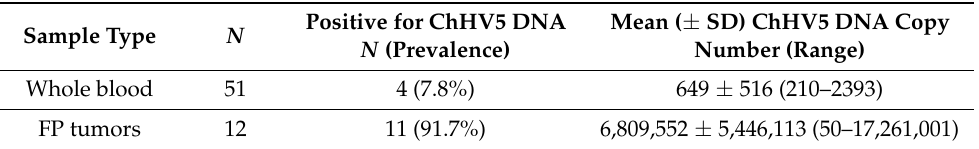
Table 2. Summary of qPCR data on ChHV5 DNA copy numbers in whole blood and fibropapilloma samples collected from Kemp’s ridley sea turtles ( Lepidochelys kempii ). Gene target of the qPCR assay